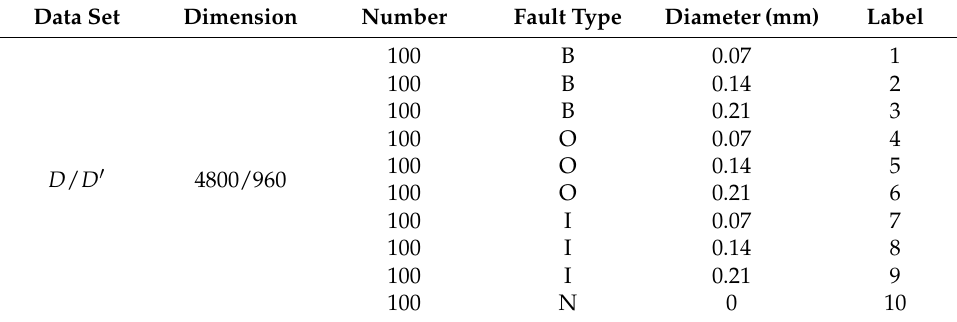
Table 1. Bearing Data Set D / D (cid:48)